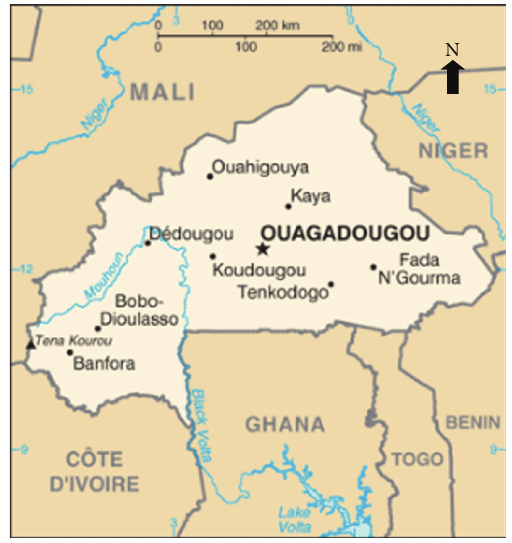
Figure 1: Location of the experimental site. Source: modified from CIA(fromCentralIntelligenceAgency:https://www.cia.gov/library/